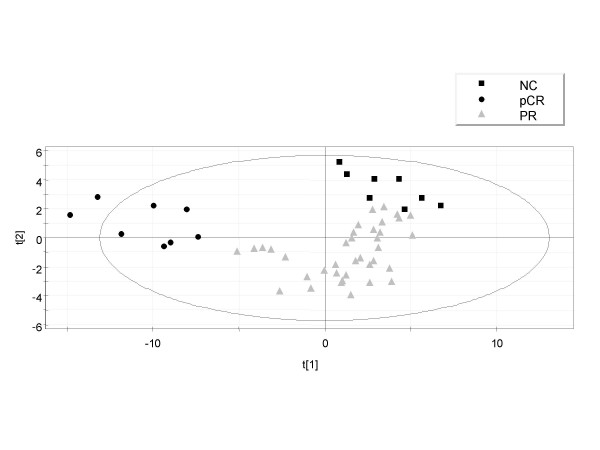
PLS discrimination according to tumor response class using the variables selected by PLS (VIP > 1.9) and ratio (pCR/NC) > 1.9 or < 0.55. Model 2 (class 1 – pCR, black dots; class 2 – NC, black squares and PR, gray triangles); 90 probe sets retained.